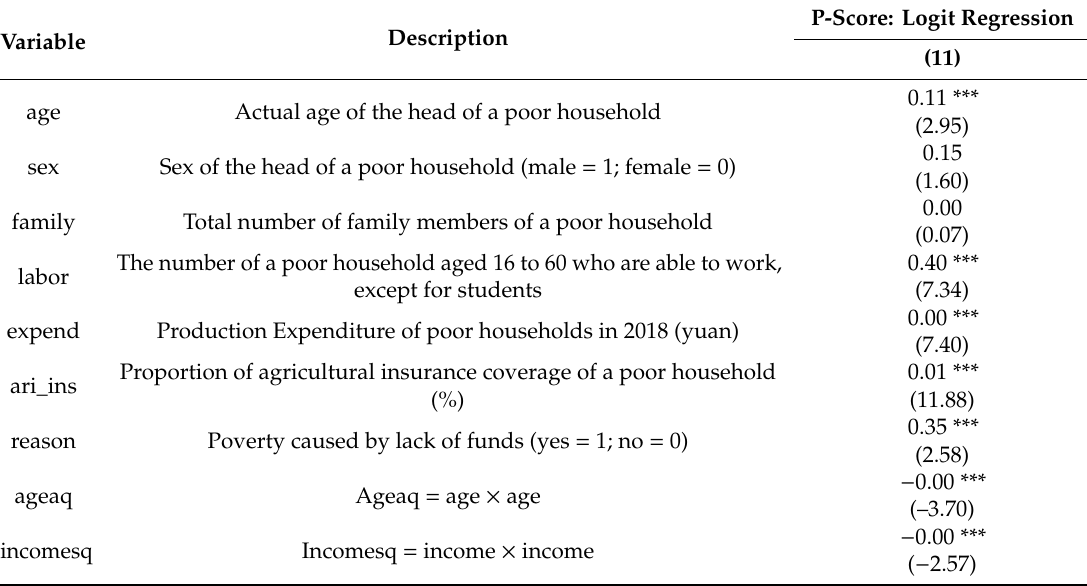
Table 3. The propensity score estimation results of matching